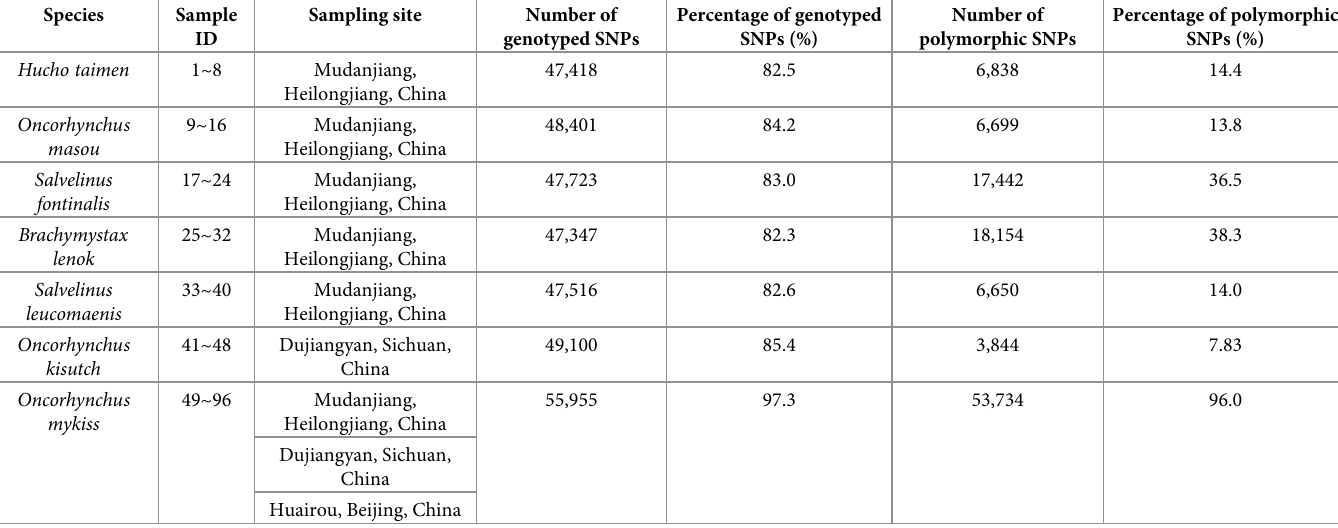
Table 1. Summary of polymorphic SNPs in seven cultured salmonid